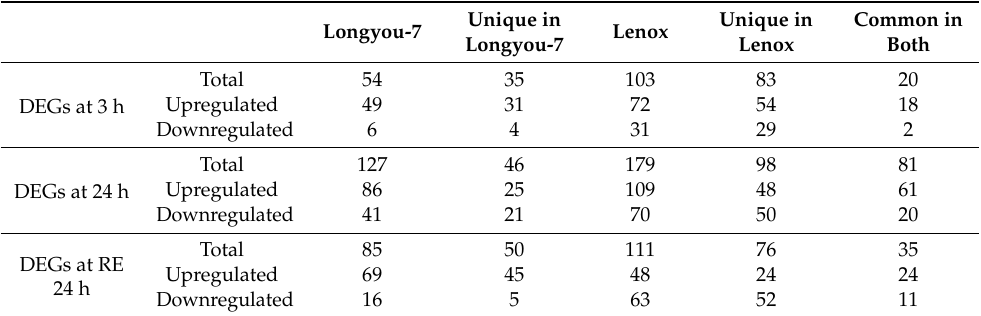
Table 2. Differentially expressed genes (DEGs) of cold stress in Longyou-7 and Lenox during cold treatment for 3 and 24